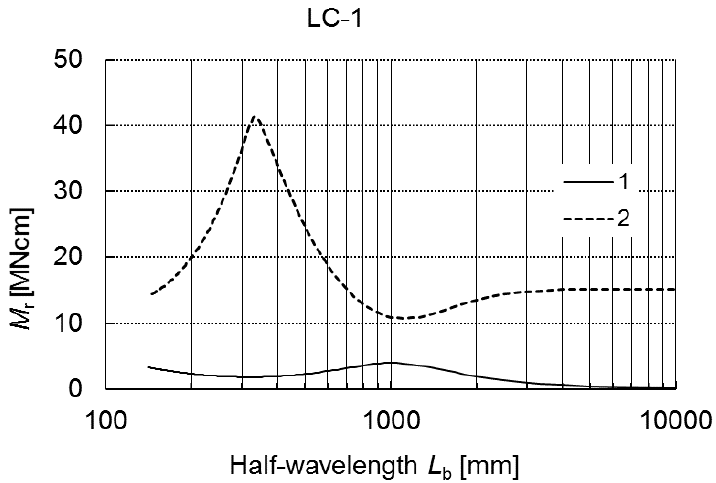
Figure 2. Buckling moments M r as a function of the buckling half-wavelength L b for LC-1. The lower curve (denoted as curve 1) corresponds to the lowest values of buckling loads, often referred to as primary buckling loads. The upper curve (marked as curve 2) refers to higher critical values, which can be called secondary buckling loads.